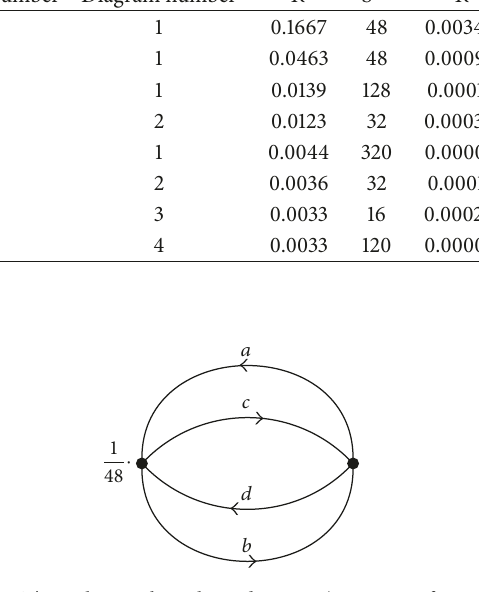
Figure 1: The only 2PI three-loop diagram (symmetry factor 1/48 , 𝑅 = 1/6